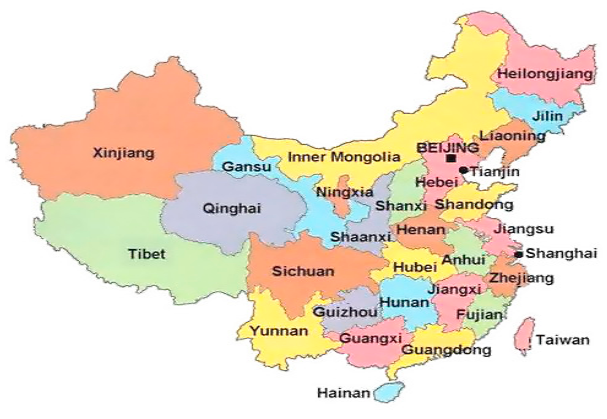
Figure 1. Research area. Table 3. Provincial transportation carbon emissions during 2007 to